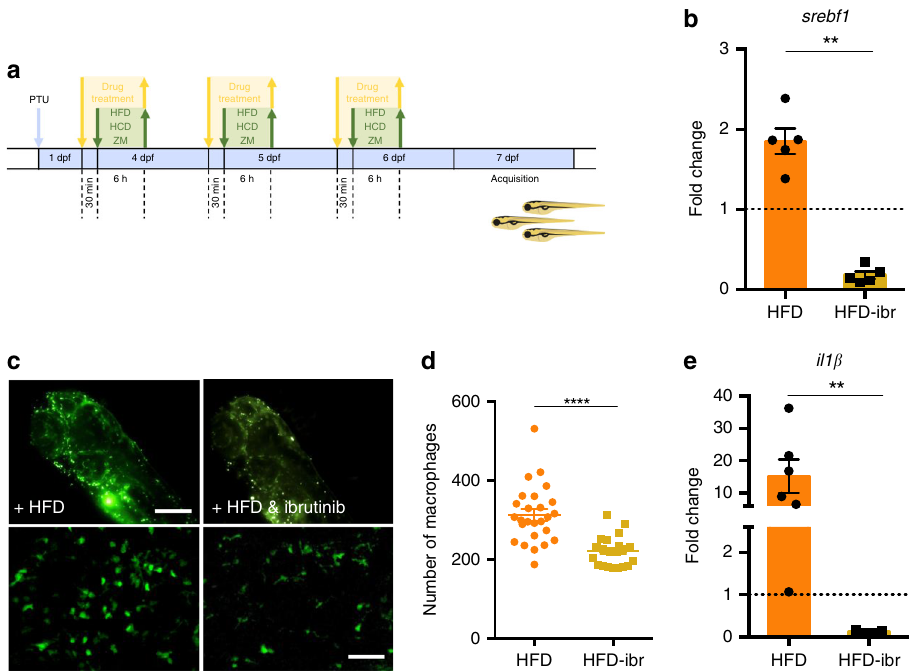
Fig. 9 High fat diet effects can be prevented by ibrutinib treatment. a Schematic representation of the protocol used for ibrutinib treatment. Zebra fi sh larvae were treated with 5 μ M ibrutinib 30 min before and during each feeding period. b Quantitative PCR analysis of the expression of srebf1 in larvae fed and treated as indicated. The error bars show the standard error of the mean (SEM); ** p -value < 0.01, n = 5 (Mann – Whitney test). c Representative images of the macrophages from the head + yolk regions of larvae obtained using the Operetta without (i) and with treatment (ii). Calibration bar: 100 μ m. In i ′ -ii ″ the macrophages are shown at higher magni fi cation (calibration bars: 50 μ m). d Quanti fi cation of fl uorescent macrophages in HFD-fed larvae without and with ibrutinib treatment. Data are pooled from three or more experiments ( n > = 21) and the charts show the mean ± the standard error of the mean (SEM). ** p -value < 0.01 (Student ’ s t -test). e Quantitative PCR analysis of interleukin-1 β ( il1 β ) expression in larvae fed and treated as indicated. ** p -value